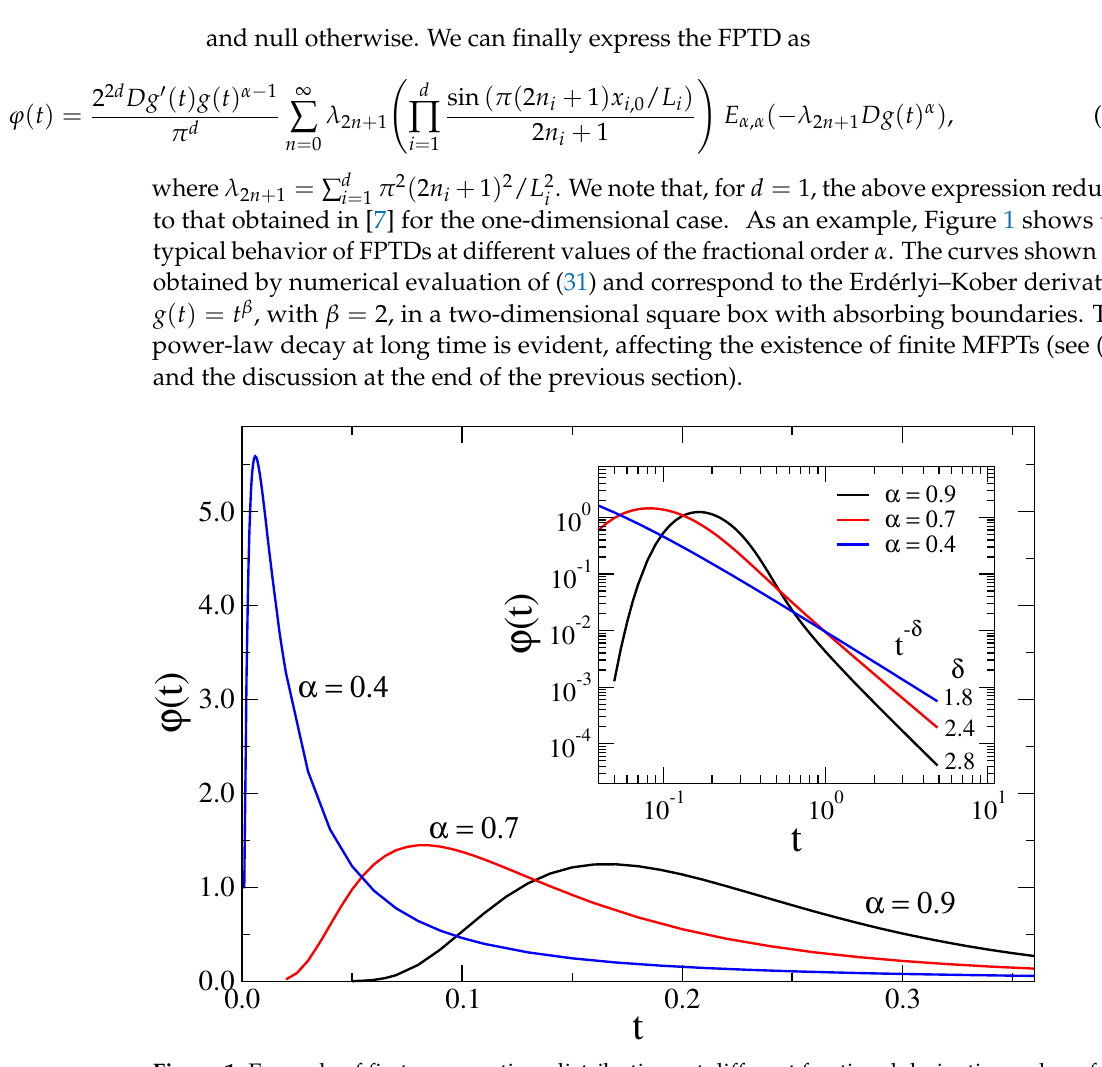
Figure 1. Example of first-passage time distributions at different fractional derivative order α for a particular choice of the g -function, g ( t ) = t 2 (Erdérlyi–Kober derivative). Inset: the same as in the main panel in logarithmic scale, in order to highlight the long time behavior t − δ . Only the cases for which δ = 1 + 2 α > 2 correspond to finite values of the MFPT (see (20) and subsequent discussion). The curves are obtained by numerical evaluation of the expression (31), considering a square box ( d = 2) of size L = 1 and setting D = 1, x 1,0 = x 2,0 = L /2, and g ( t ) = t 2